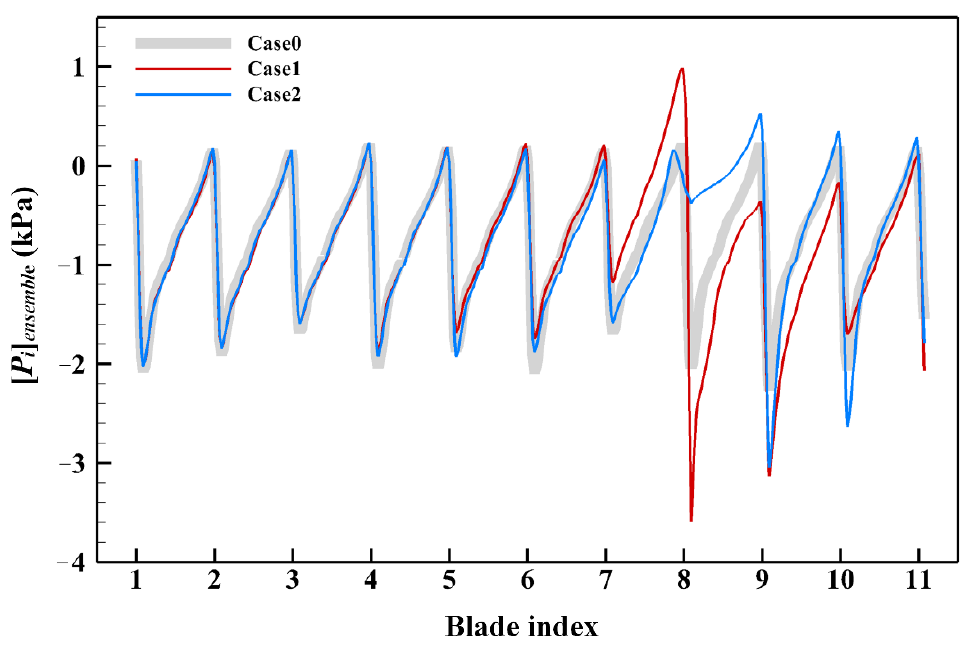
Figure 8. Blade passing signal for three stagger angle settings (Φ = 0.580).